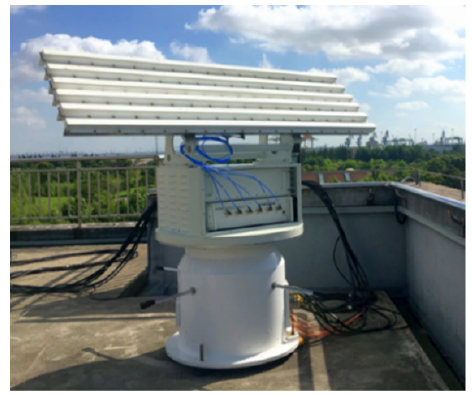
Figure 2. The ground-based MIMO radar system for LSS target detection.